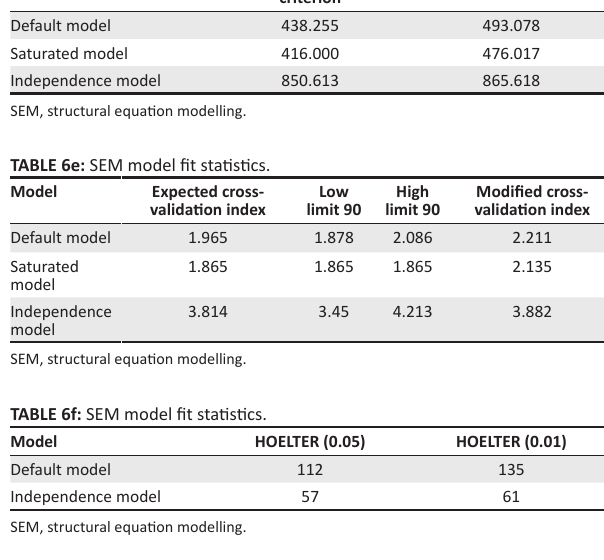
TABLE 6d: SEM model fit statistics. Model